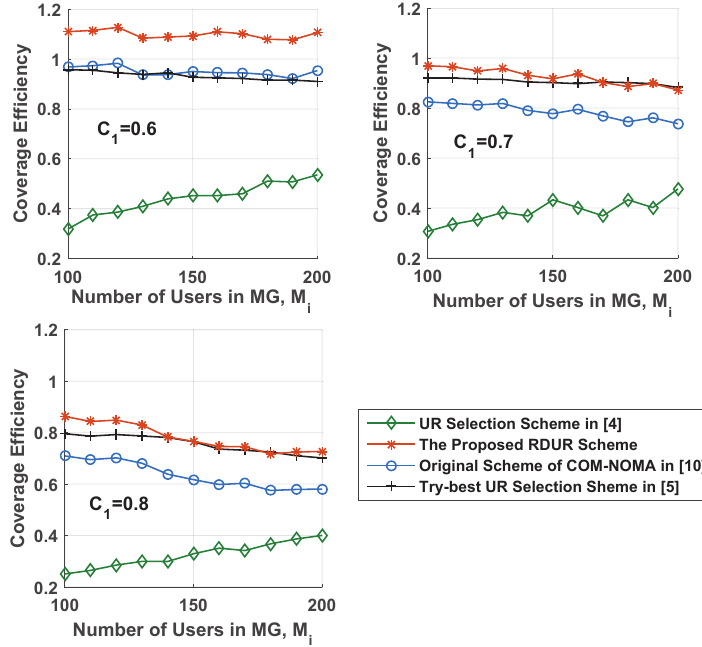
Figure 7. Coverage efficiency versus the number of users in MG, in different C 1